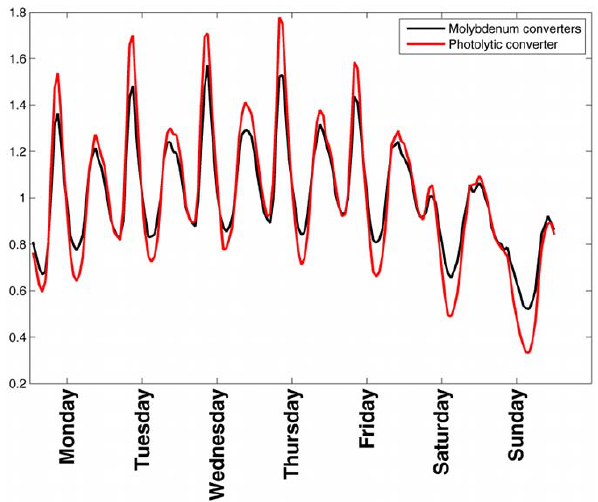
Fig. 7. Normalized weekly cycle of NO 2 of simultaneous measure- ments using a molybdenum converter and a photolytic converter av- eraged over a 3yr time series (2006–2009) at the site Payerne in